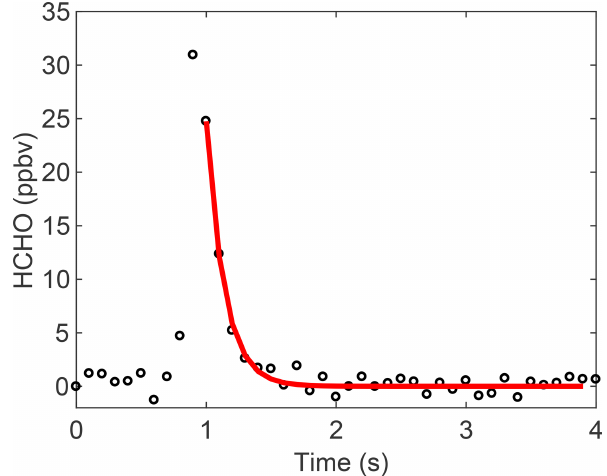
Figure 7. Normalized Allan–Werle deviation versus averaging time for [HCHO] = 6ppbv. HCHO precision improves with averaging up to ∼ 200s. A linear fit (red dashed line) to the data up to 256s gives a slope ( − 0 . 58) similar to the value expected from white noise (0.5).